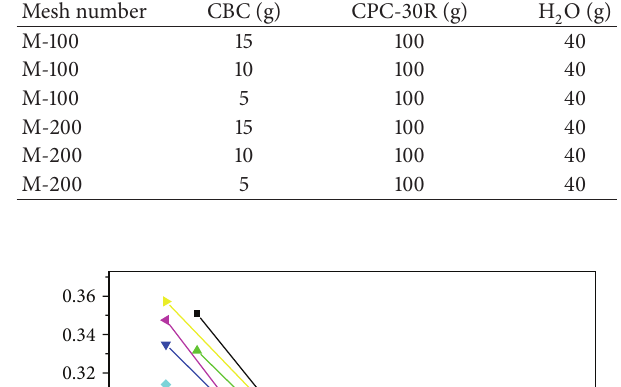
Table 1: Composition of composite materials (CBC/CPC-30R/ H 2 O).